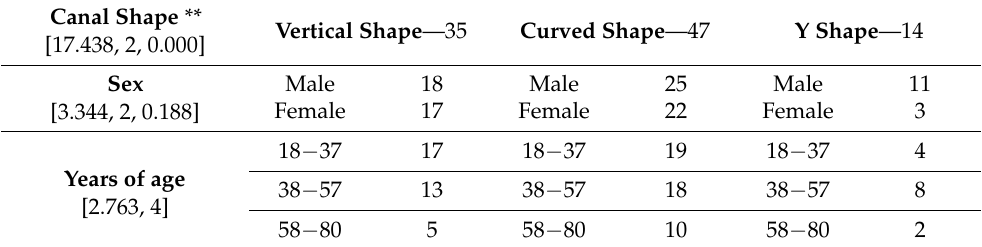
Table 3. Accessory canal localization.